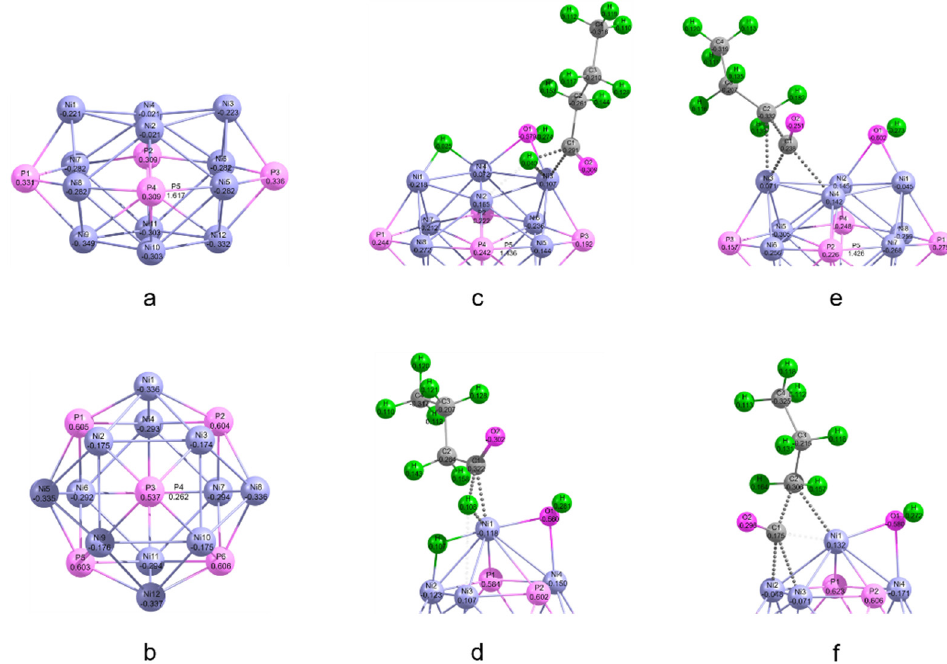
Figure 12. Mulliken charges for ( a ) Ni 12 P 5 cluster, ( b ) Ni 12 P 6 cluster, ( c ) F3-TS3 over Ni 12 P 5 cluster, ( d ) 3-TS3 over Ni 12 P 6 cluster, ( e ) F5-TS2 over Ni 12 P 5 cluster, and ( f ) 5-TS2 over Ni 12 P 6 cluster, respec- tively.